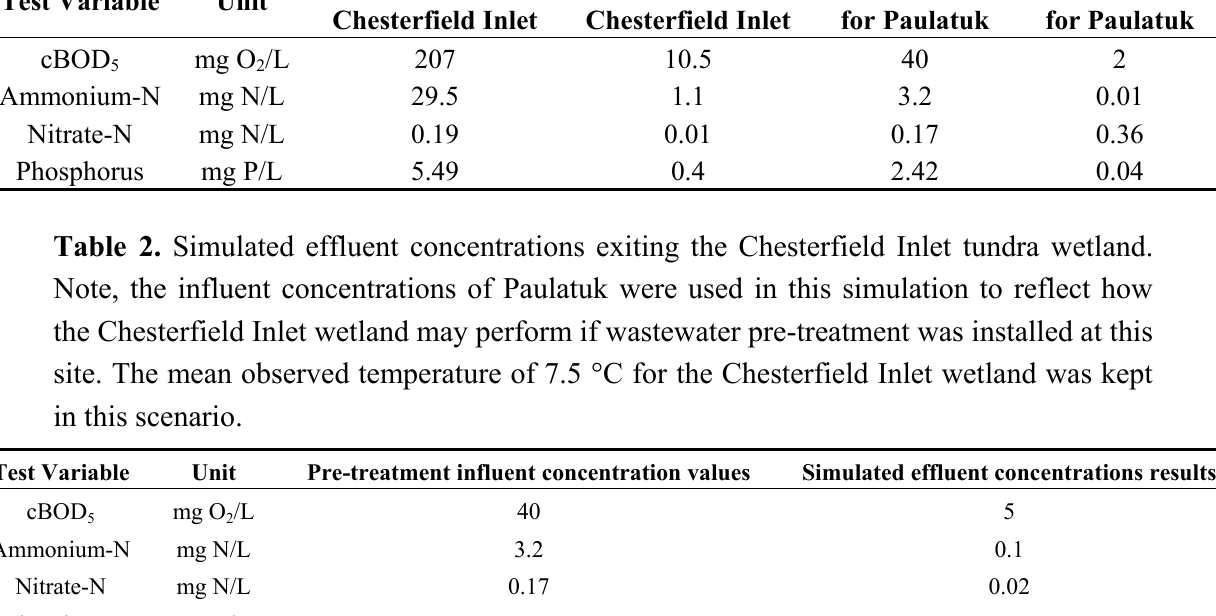
Table 1. Measured influent and effluent concentrations observed at both the Chesterfield Inlet and Paulatuk tundra wetlands. The influent entering the Chesterfield Inlet was not pre-treated, while the influent entering the Paulatuk tundra wetland had undergone pre-treatment in the facultative lake immediately upstream of the wetland.